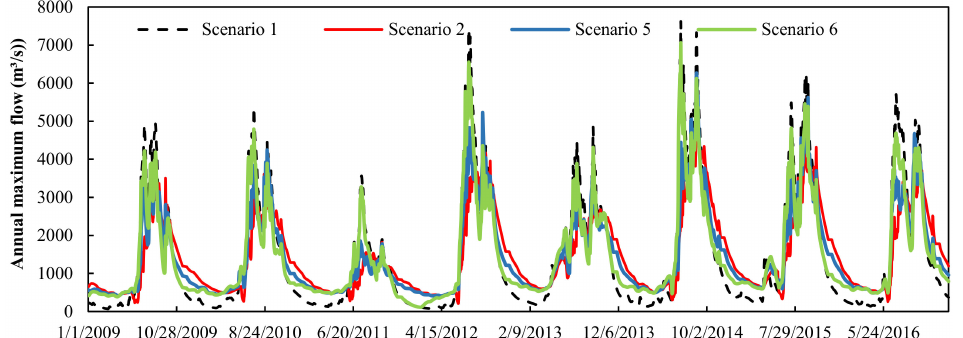
Figure 7. The daily simulation results of runoff (2009–2016) at Ertan station (Scenarios 1–2 & 5–6). Table 7. Flood characteristics analysis at Ertan station (Scenarios 1–2 & 5–6). (Q max represents